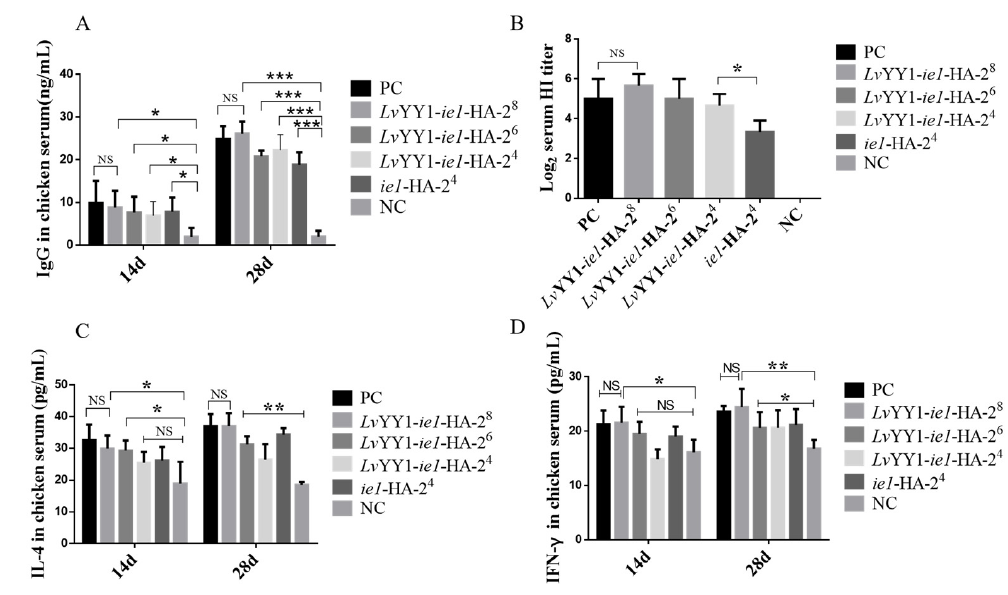
Figure 7. Efficient immunogenicity of BV- Lv YY1- ie1 -HA in chickens. Two-week-old specific pathogen-free (SPF) chickens were randomly divided into 6 groups (A, B, C, D, E, and F, n = 5). Groups A to C were respectively immunized twice with different hemagglutination titers (2 8 , 2 6 , 2 4 ) of 200 μ L live baculoviruses containing HA antigen without adjuvant (BV- Lv YY1- ie1 -HA). Group D was immunized with 200 μ L 2 4 hemagglutination titers of BV- ie1 -HA. Group E was immunized with emulsified commercial inactivated vaccine as a positive control (PC). Group F was immunized with PBS as a negative control (NC). ( A ) Detection of HA-specific antibodies in chicken serum with ELISA. ( B ) Three serum samples were randomly collected on day 28 from each group for measuring the serum hemagglutination inhibition (HI) titer. ( C ) Serum IL-4 concentration following vaccination with recombinant baculovirus vaccines. ( D ) Serum IFN- γ concentration following vaccination with recombinant baculovirus vaccines. Results show mean ± SD for three independent experiments. * p < 0.05, ** p < 0.01, *** p < 0.001, unpaired Student’s t -test.